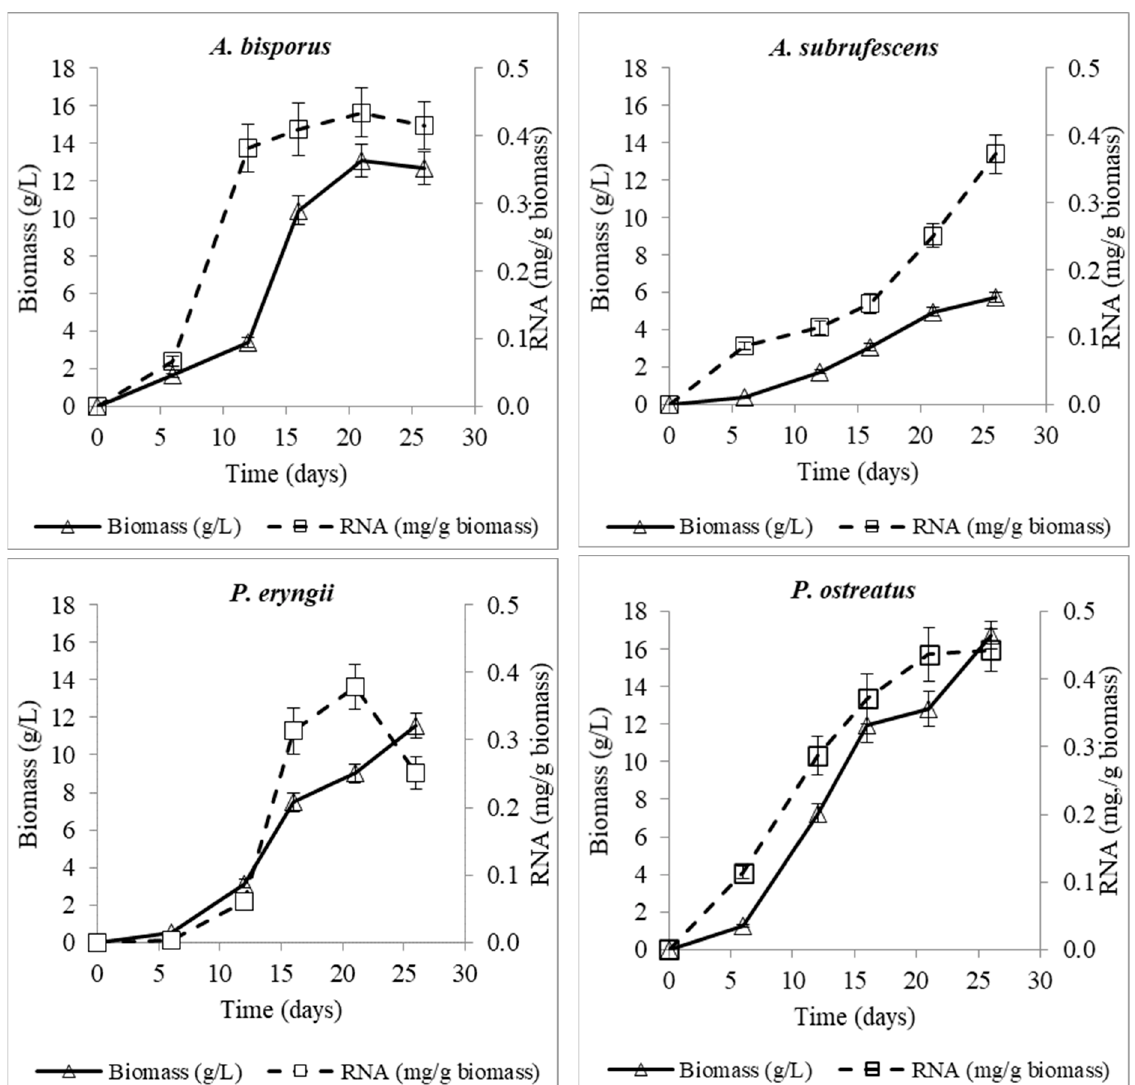
Figure 3. Produced biomass and RNA levels of A. bisporus , A. subrufescens , P. eryngii and P. ostreatus during their cultivation in agitated (120 ± 5 rpm) liquid cultures of C/N molar ratio 20, at 26 ± 1 °C .